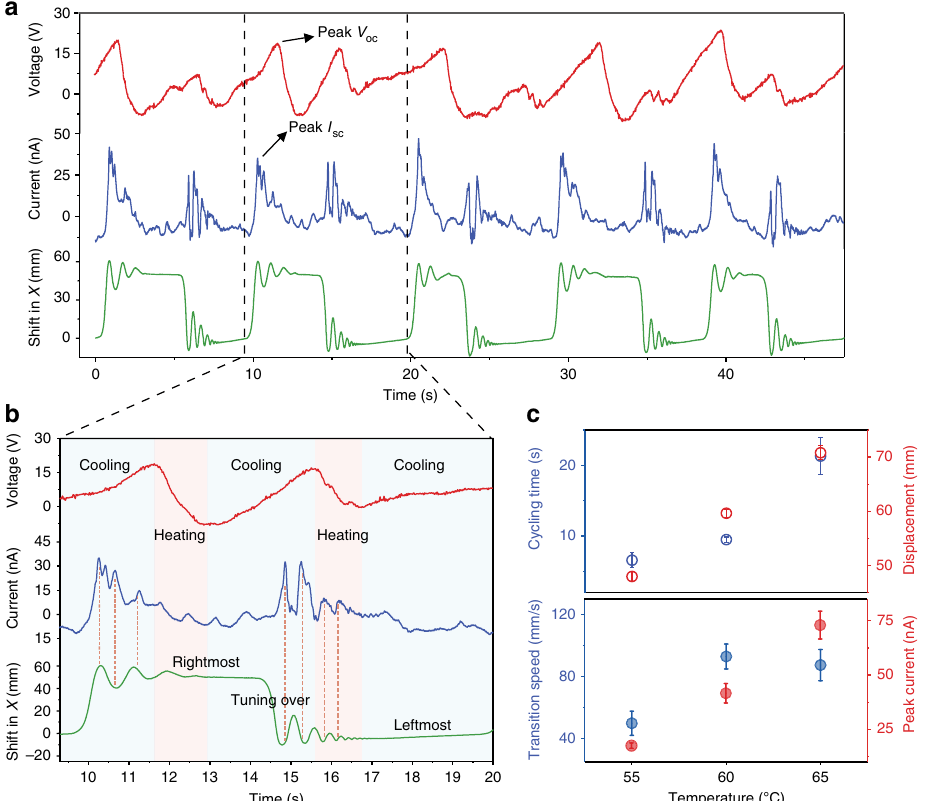
Fig. 5 Thermomechanical locomotion energy harvesting utilizing the pyro/piezoelectric effect. a Time-dependent shifting in the x -axis, short circuit current and open circuit voltage of TMES ( α = 90°) during fi ve consecutive oscillation cycles on the hot surface at 60 °C and b magni fi cation in one oscillation cycle. c Average cycling time, maximum displacement, transition speed, and peak I sc at 55, 60, and 65 °C. Error bars represent